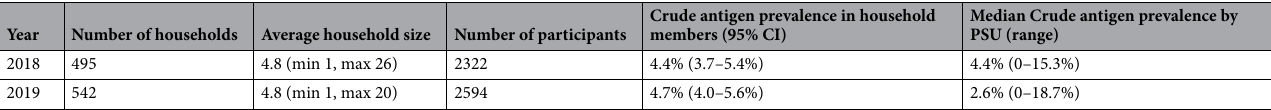
Table 1. Study population and observed antigen prevalence from 2018 and 2019 household surveys. Sample size and crude antigen prevalence from household surveys across 35 primary sampling units in Samoa (participants aged ≥ 5